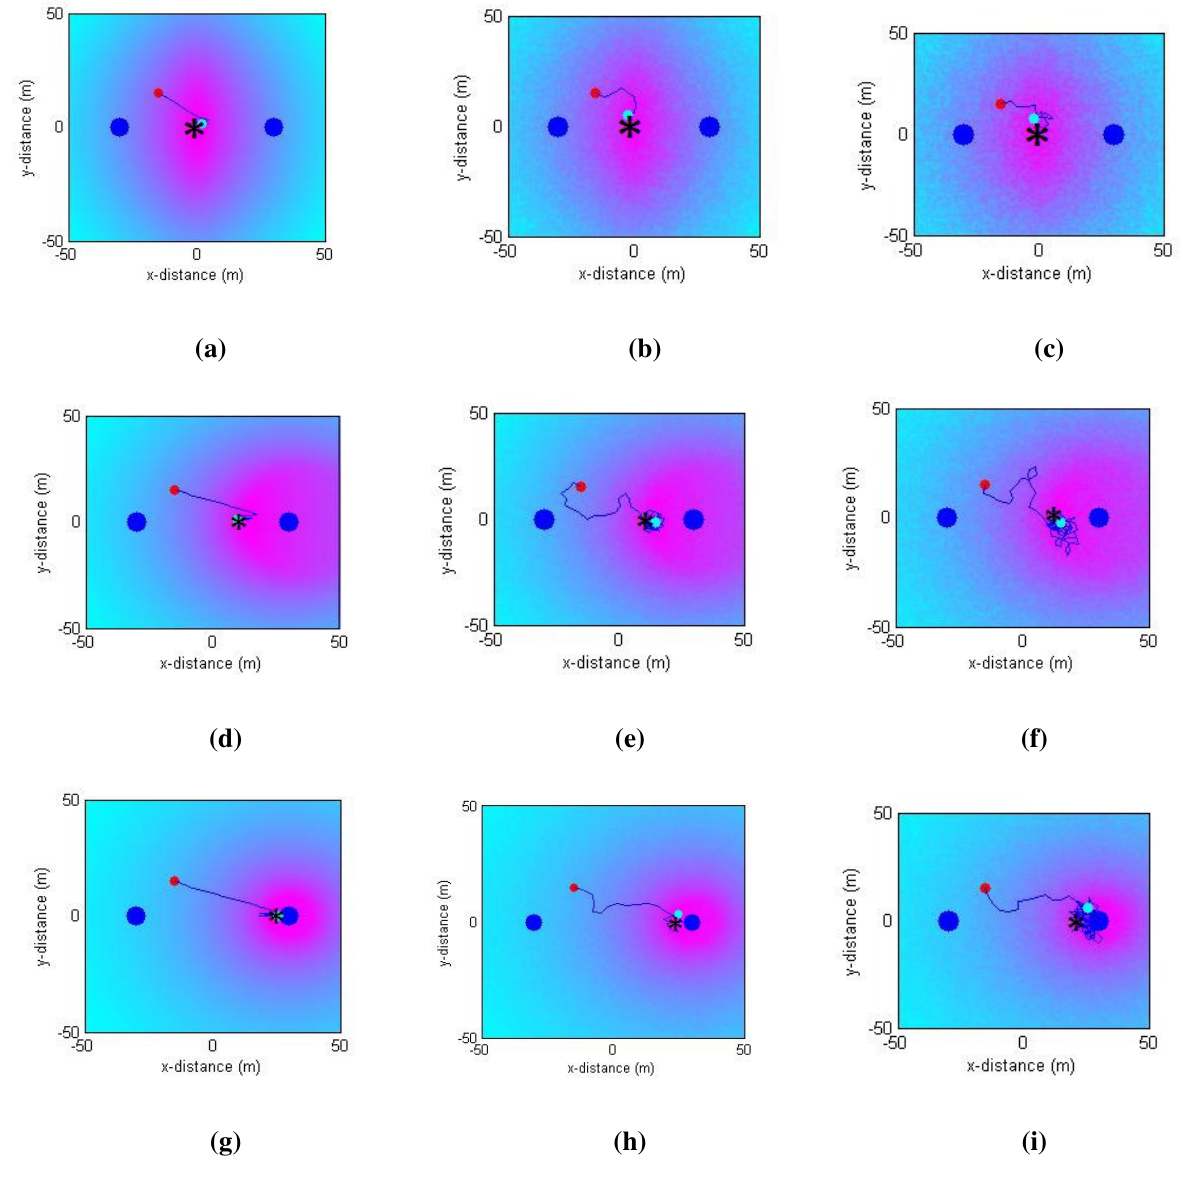
Figure 11. Path taken by the relay node and the objective function value for all scenarios. The theoretical optimum positions are indicated as *. ( a ) LOS, without noise; ( b ) LOS, with 1-dBm noise; ( c ) LOS, with 2-dBm noise; ( d ) NLOS, without noise; ( e ) NLOS, with a 1-dBm noise; ( f ) NLOS, with 2-dBm noise; ( g ) Deep-NLOS, without